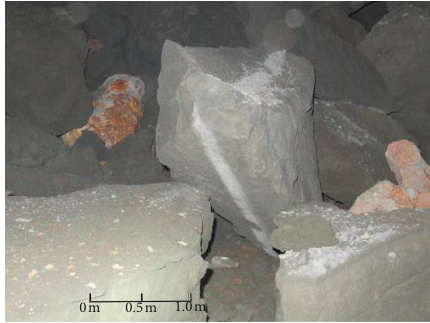
Figure 1: Underground backfill